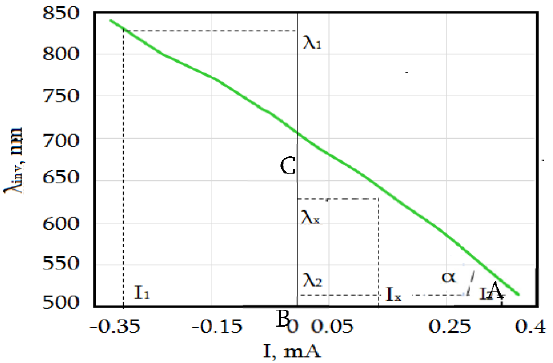
Figure 4. The dependence of the position of the inversion point of the spectral photocurrent on the photocurrent of the absorbed integral radiation.